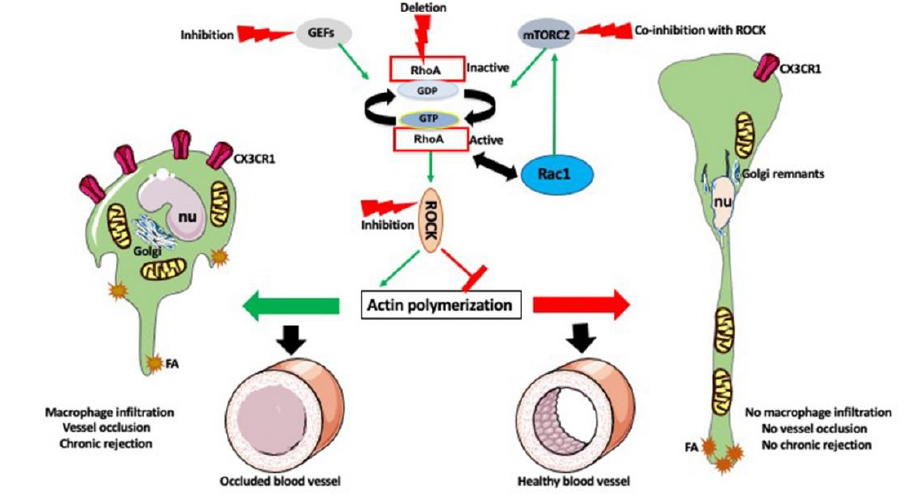
Figure 6. Effect of the RhoA pathway inhibition on macrophages and chronic rejection. RhoA is regulated by GEFs. It is also affected by the mTORC2 pathway and reciprocally interacts with Rac1, which in turn affects the mTORC2 pathway. All these pathways regulate actin polymerization and actin-dependent functions of macrophages. After transplantation, the macrophages infiltrate the graft and cause vessel occlusion, fibrosis, and chronic rejection ( left panel ). Inhibition of RhoA pathway (or co-inhibition of RhoA and mTORC2), or macrophage specific deletion of RhoA, disrupts actin polymerization and actin-dependent functions, causes extreme elongation (hummingbird phenotype), dispersion of the Golgi, and relocation of the nucleus (nu) and mitochondria toward the tail. It also inhibits the expression of CX3CR1 receptors and aggregates the focal adhesions (FA) at the tip of the tail. All these changes prevent macrophage movement into the graft and prevent vessel occlusion and chronic rejection ( right panel ).